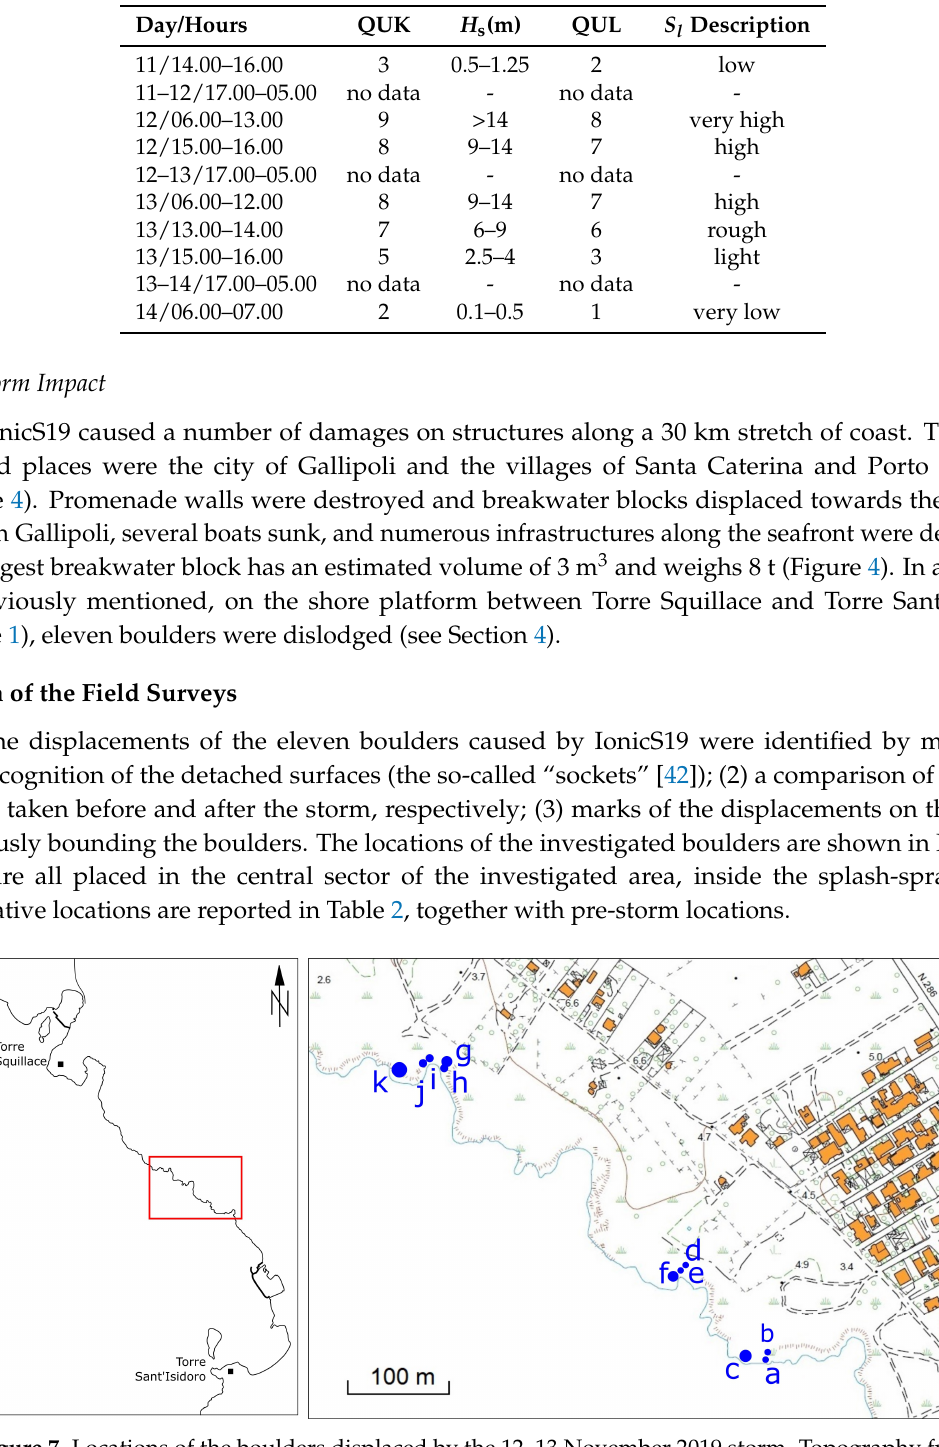
Figure 7. Locations of the boulders displaced by the 12–13 November 2019 storm. Topography from the technical map of the Lecce Province